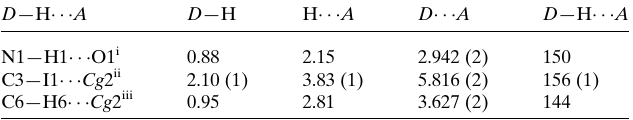
Table 2 Hydrogen-bond geometry (A˚ , (cid:3) ) for (II). Cg 2 is the centroid of the C8–C13 benzene ring.